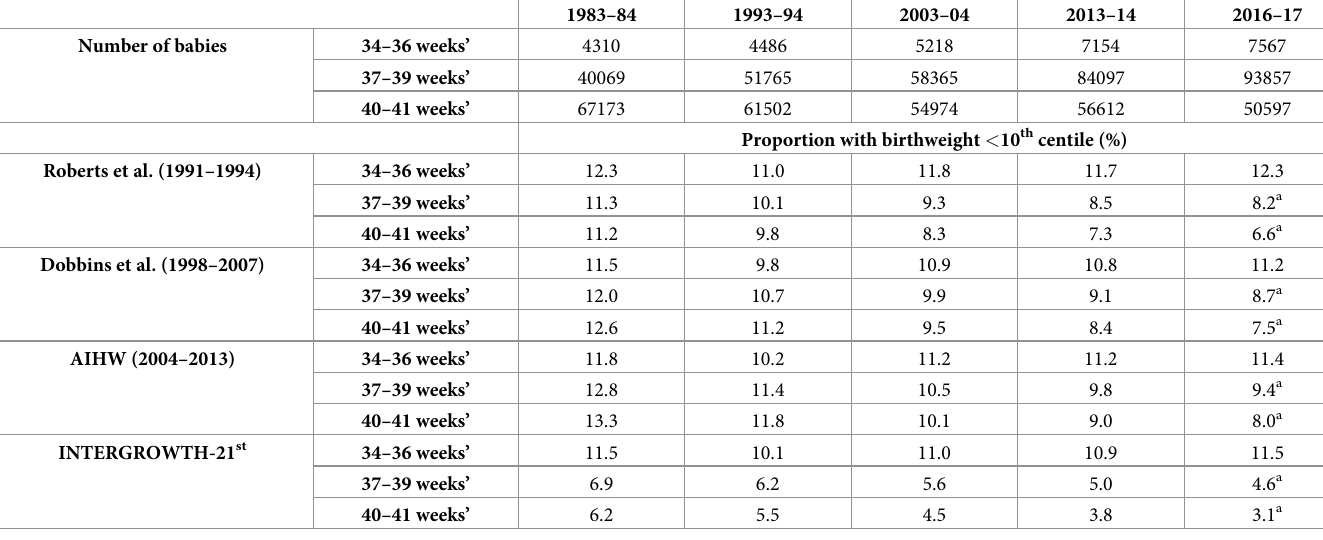
birthweight < 3 rd and < 10 th centile than the population birthweight charts. For the Australian population, these observations suggest that population-based descriptive birthweight centiles are superior to externally-derived prescriptive birthweight standards, but should not be updated over time. Table 5. Proportion (%) of babies born with birthweight < 10 th centile at preterm, early term and late term gestations in each two-year epoch by birthweight centile